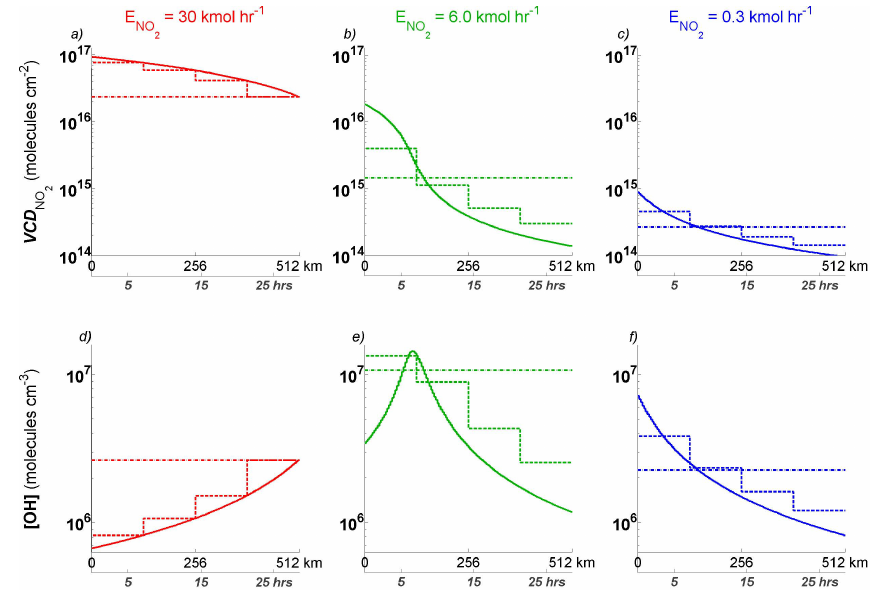
Fig. 2. NO 2 column (moleculescm − 2 ) predicted in a 1-D plume model at 2km (solid), 128km (dashed), and 512km model resolutions (dash-dot) for (a) a large, (b) intermediate, and (c) small source of NO 2 and (d–f) the corresponding OH feedback. The color-scheme corresponds to NO 2 -OH feedback regimes depicted in Fig. 1. Horizontal (N–S) and vertical layers are fixed at 1km thickenss for all resolutions.